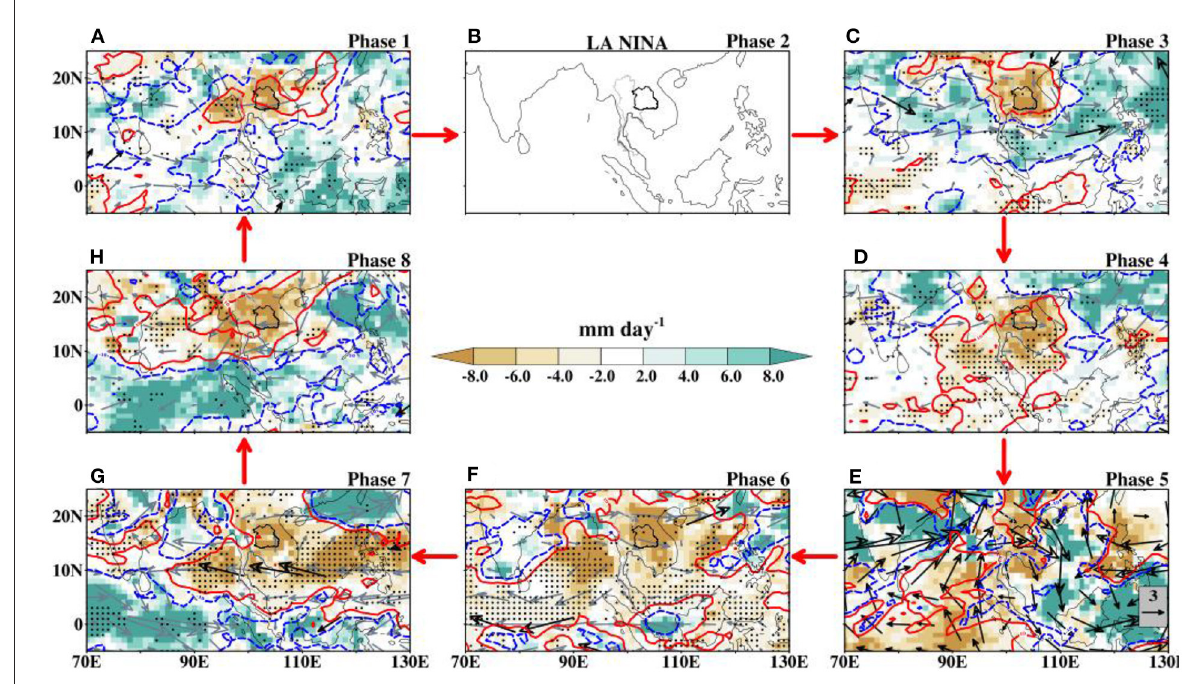
FIGURE13 (A–H) Same as Figure 12 but for La Niña and active BSISO phases.